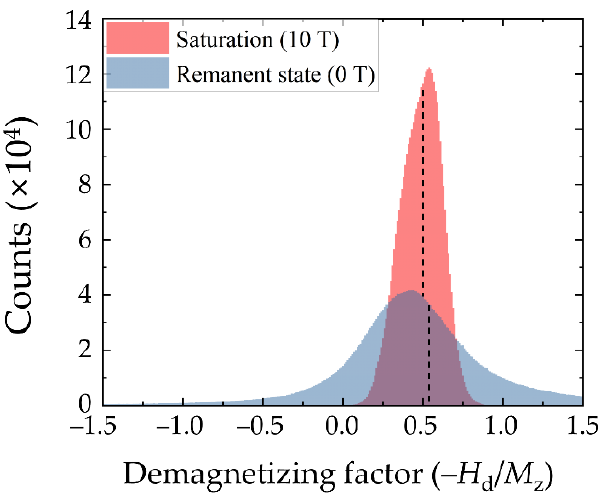
Figure 5. Distribution of the demagnetization factors (– H d / M z ) of each element at saturation (red) and in the remanent state (blue). The black dashed lines indicate the 10% truncated means.